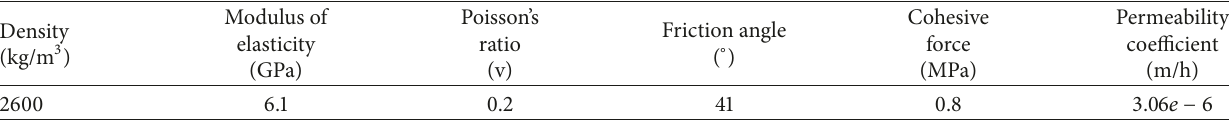
Table 2: Parameters of grouting